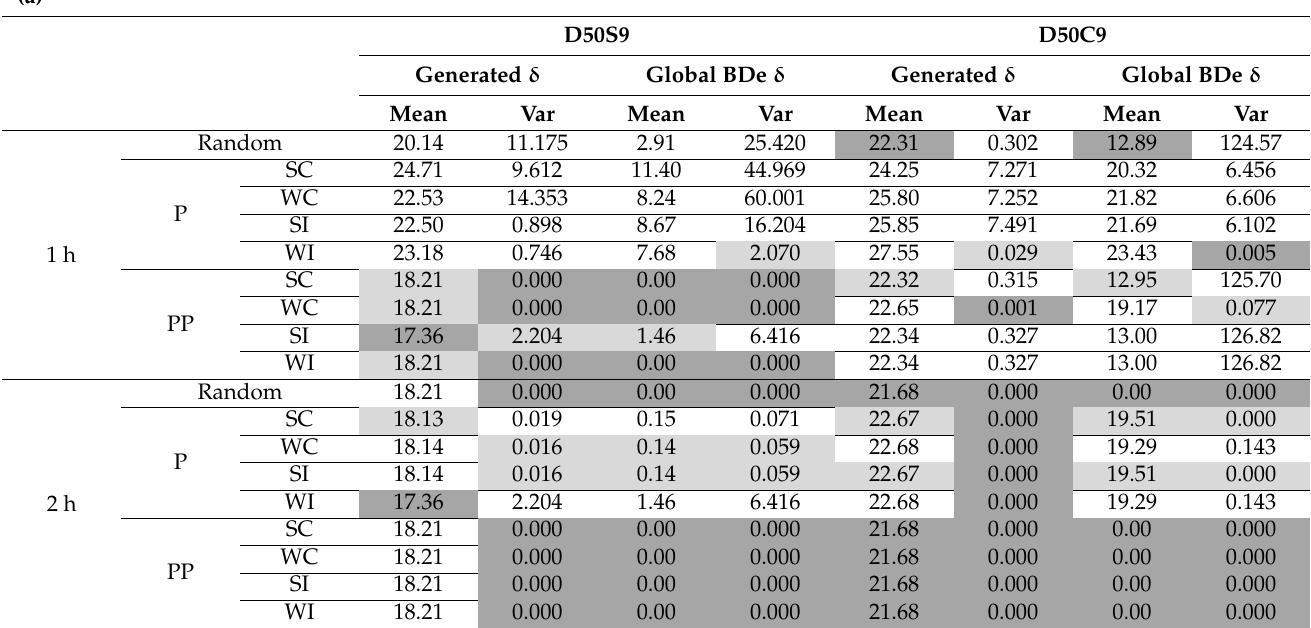
Table 4. Structure distances without the order weight. (a) 50 cases datasets. Dark shaded cells represent the lowest distance or variance in each timed run for the dataset; Bright shaded cells represent the second lowest distance or variance in each timed run for the dataset. (b) 1000 cases datasets. Dark shaded cells represent the lowest distance or variance in each timed run for the dataset; Bright shaded cells represent the second lowest distance or variance in each timed run for the